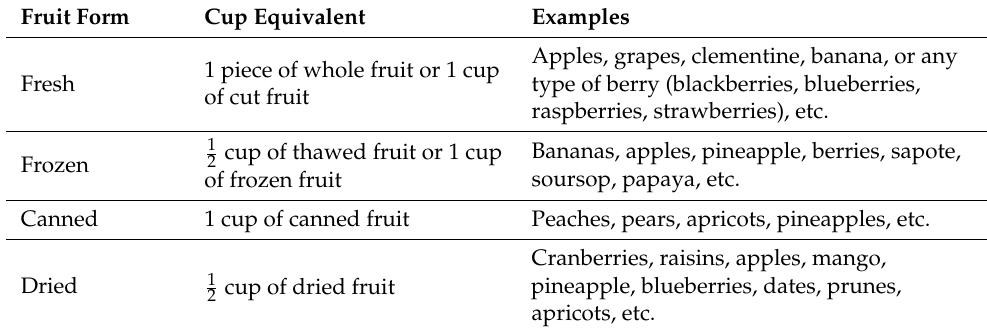
Table 3. MyPlate’s Fruit Group with Examples for Each Fruit Form and Recommended